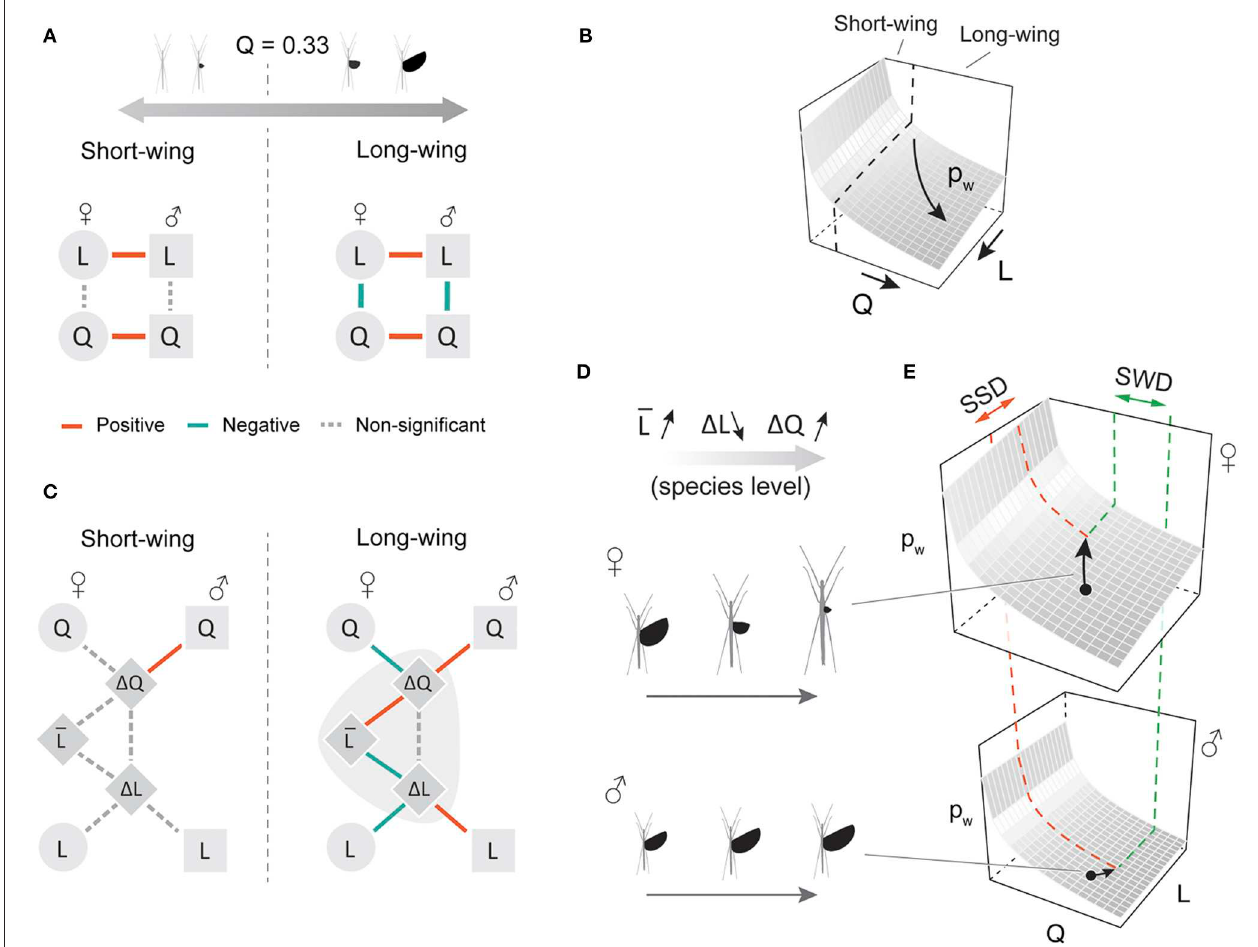
FIGURE 7 | Phylogenetic correlations between wing and body size among stick insect species. (A) An inverse correlation between wing and body size was found in both sexes of long-winged species (Q > 0.33 in both sexes), indicated graphically in (B) as a coupled transition between different states of wing and body size on the wing loading landscape. (C) In long-winged species, sex-averaged L is significantly correlated with 1 L and with 1 Q, demonstrated graphically in (D) as an increasing sex-averaged L associated with decreasing 1 L (increasing SSD) and increasing 1 Q (increasing SWD). (E) Schematic scenario for consequences of increased sexual dimorphism in flight-related morphology; increases in female-biased SSD and male-biased SWD lead to greater difference in flight capability (i.e., changes in the z -position on the wing loading landscape). Details of the PGLS results are provided in Table 3 .